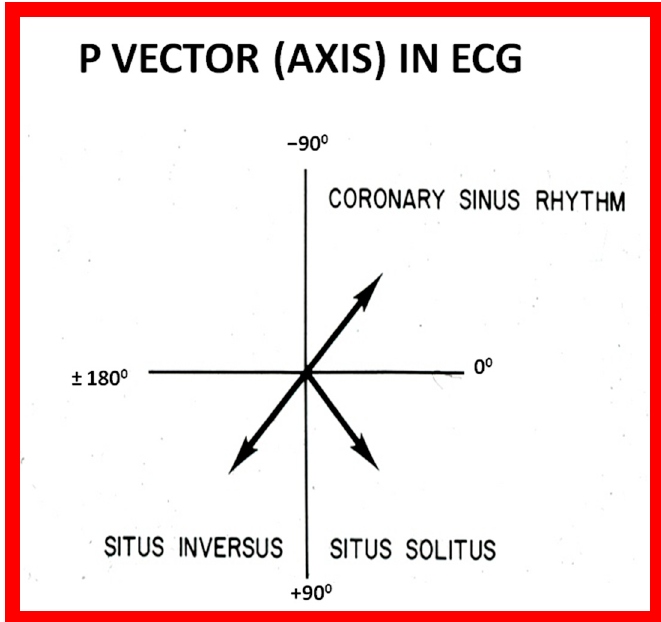
Figure 16. Diagram illustrating the utility of frontal plane P wave vector (axis). Axis of the P wave in-between 0° and +90° indicates normally positioned atria (situs solitus of the atria). Axis of the P wave in-between +90° and ±180° is suggestive of reversed atrial position (situs inversus of the atria). Axis of the P wave in-between 0 and − 90° is termed low atrial or coronary sinus rhythm; such P waves are not useful in assessing the situs of the atria. Reproduced from reference [2].